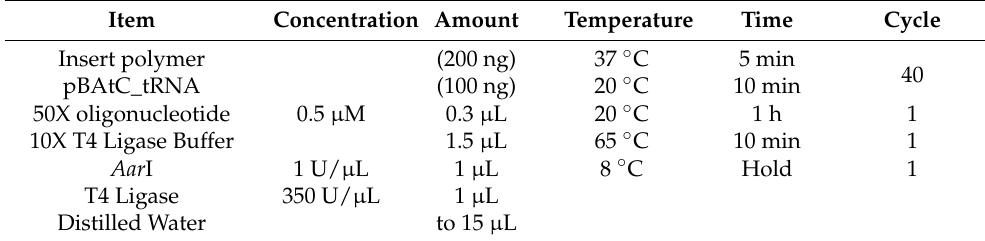
Table 13. Golden Gate reaction components and thermal